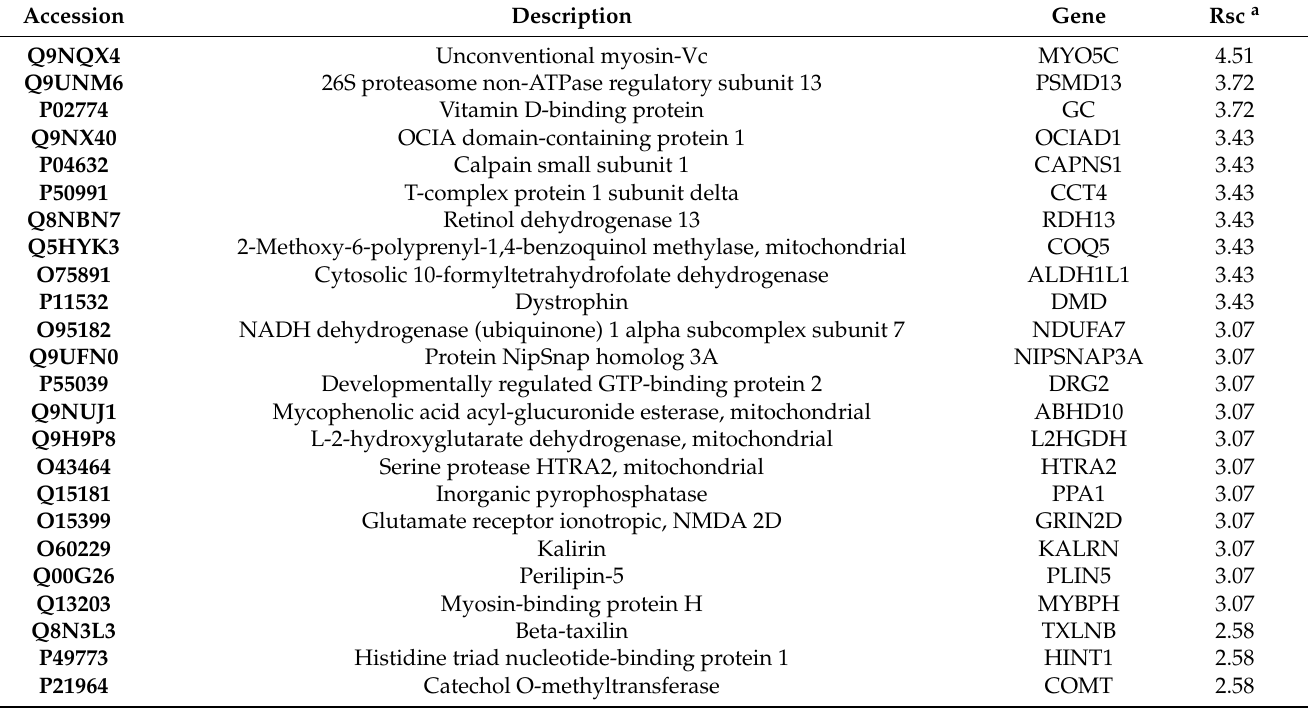
Table 2. Label-free quantitative analysis of proteins identified from V. lateralis muscle biopsies. Overexpressed proteins with Rsc ≥ 1.40 in the VPG vs. CG are